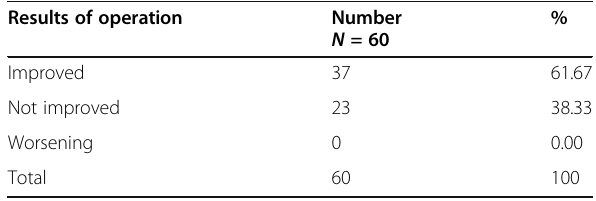
Table 10 The operation results of patient with general health score (quality of life)